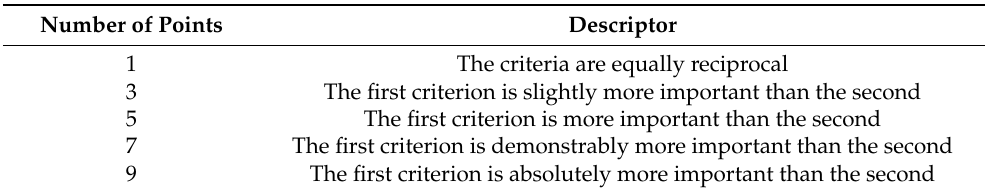
Table 7. Criteria and their preferences (own